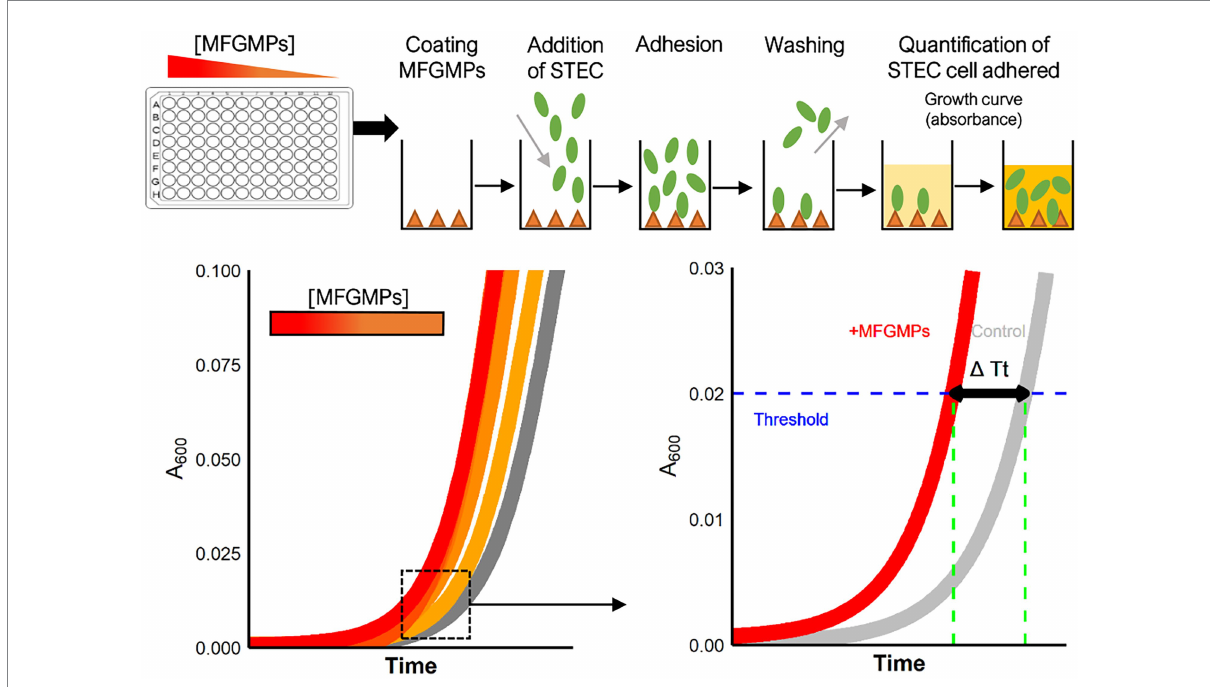
FIGURE 1 Experimental process for the plate adhesion assay. The assay was performed in sterilized 96-well plates coated with MFGMP solutions at various concentrations. E. coli cells were added to wells for 2 h at 4 ° C and the plates were extensively washed to remove non-adhering cells. Growth curves were acquired in a plate reader and a five-parameter log-logistic model was used to estimate the time of each curve to reach an absorbance of 0.02 at 600 nm (Time Threshold; Tt). The greater the number of bacterial cells adhered to the well, the shorter the time to reach the threshold. The difference in Tt ( Δ Tt in sec) with and without MFGMPs was calculated for each MFGMP coating solution, strain, and experimental